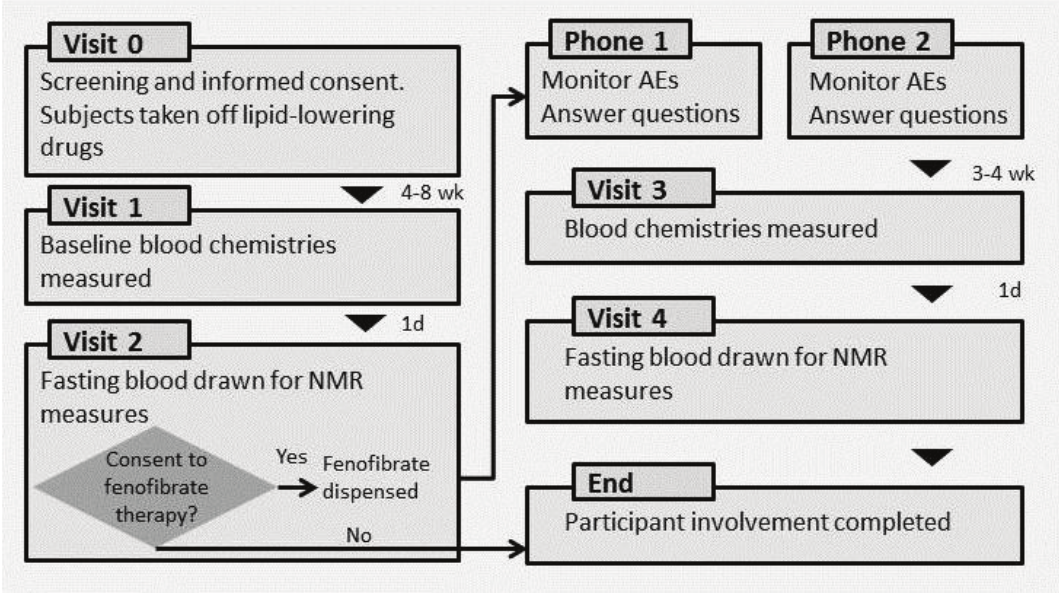
Figure 1. Details of the GOLDN